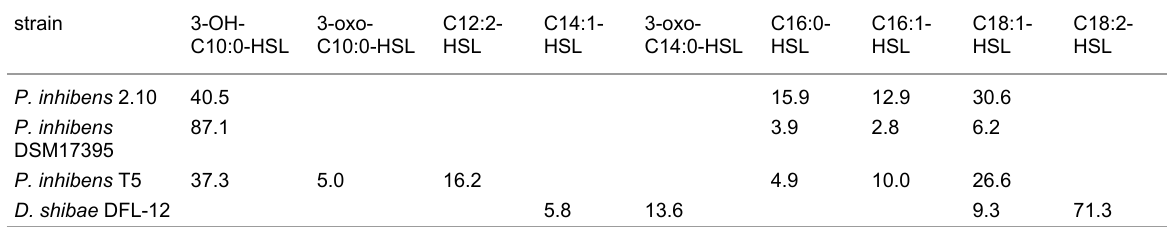
Table 1: Presence of different AHLs in four strains of Roseobacter group bacteria. a